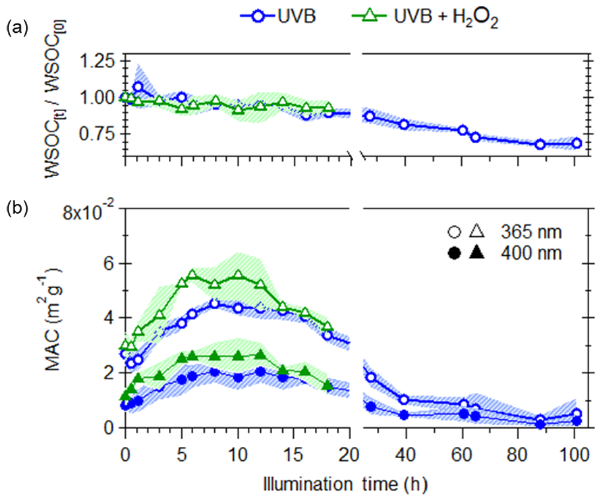
Figure 2. Effects of UVB photolysis (blue circles) and aqueous OH oxidation (green triangles) on (a) changes in WSOC (b) WSOC mass normalized absorption coefficient (MAC) at 365nm (open markers) and 400nm (filled markers). The shaded areas represent the variability ( ± 1 σ ) in multiple experiments ( n =